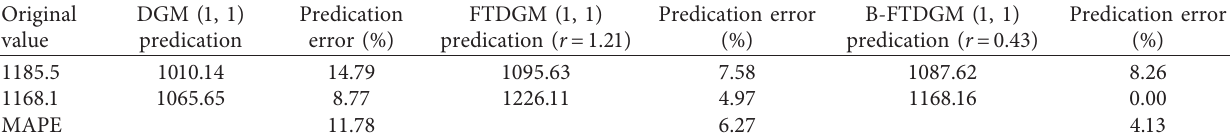
Table 4: Predication results of different grey predication